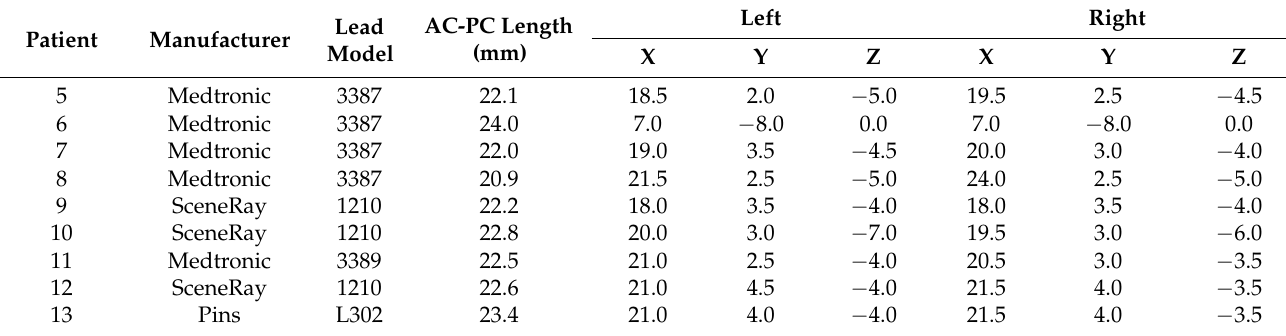
Table 3. Coordinates of the DBS targets.